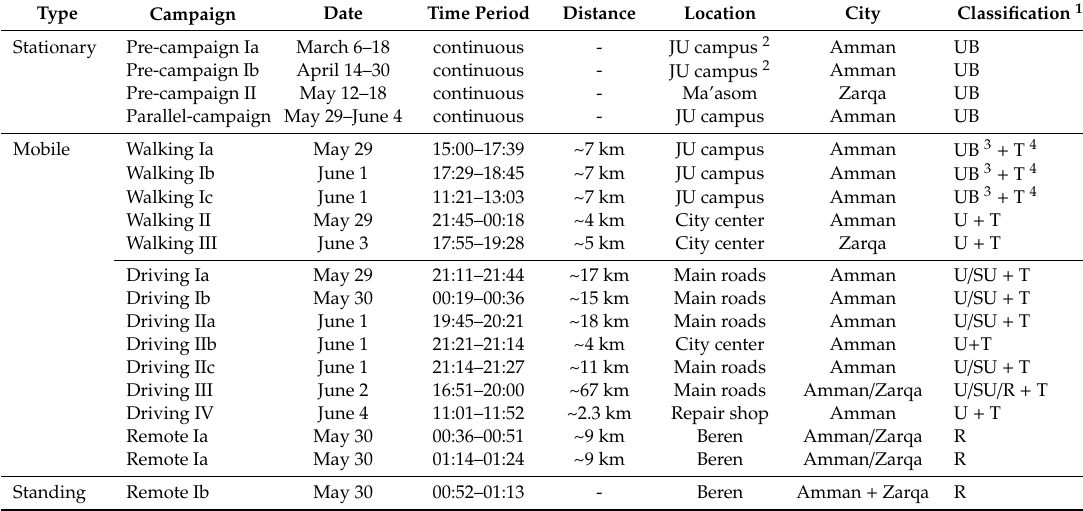
Table 1. Summary of stationary and mobile measurement